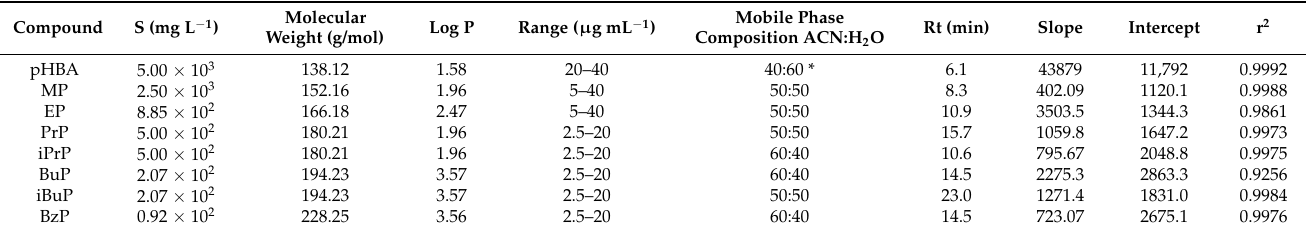
Table 1. Chromatographic and physicochemical parameters of the eight chemicals.